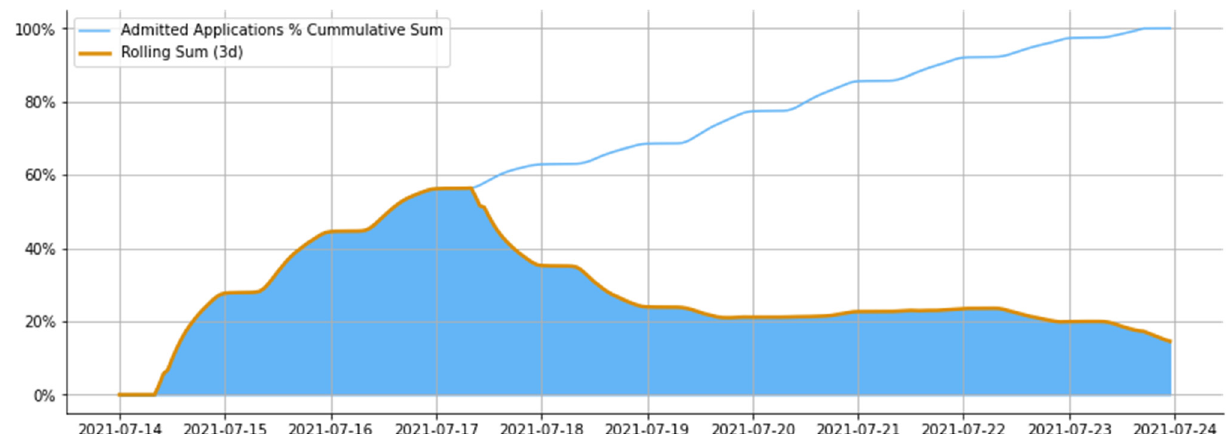
Figure 7. Admitted Applications by Submission date: cumulative sum.